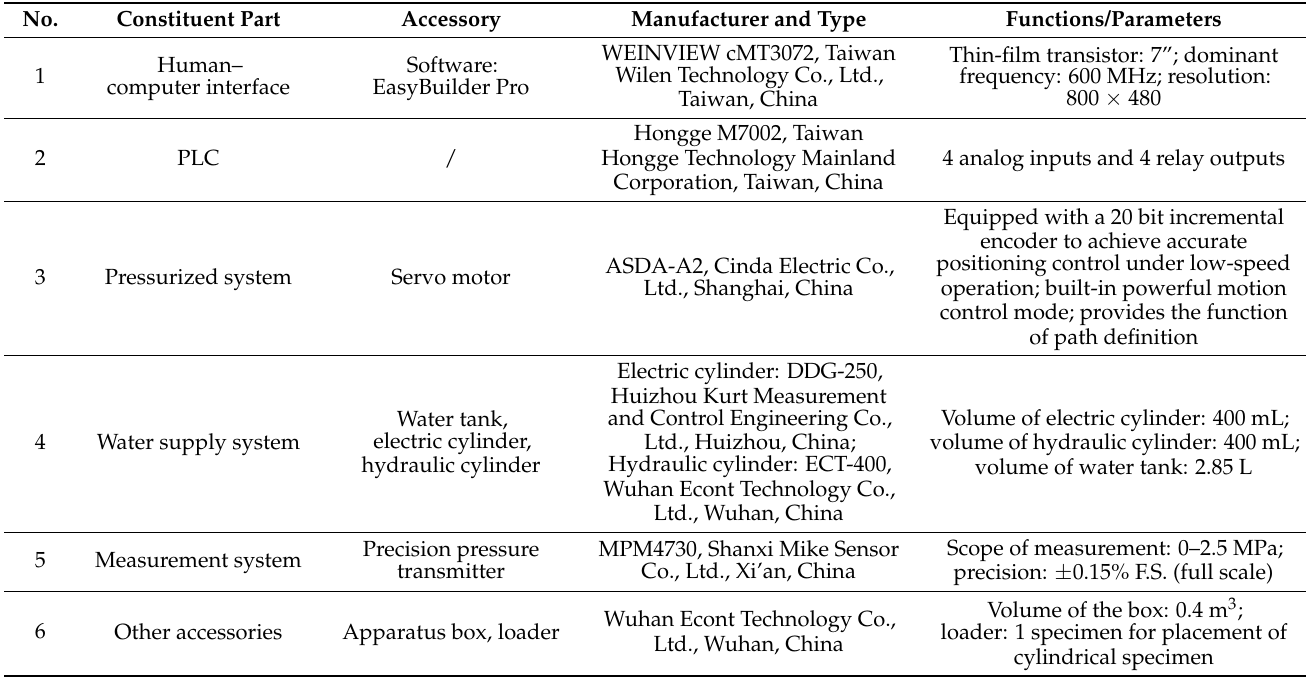
Table 1. Configuration of the seepage apparatus. PLC, programmable logic controller.